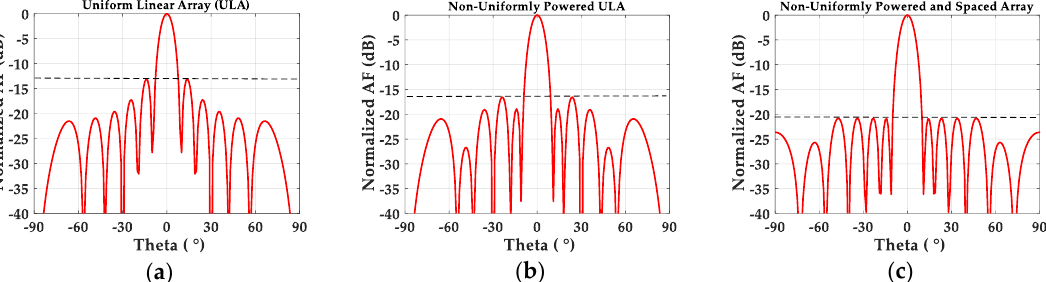
Figure 3. Normalized array factors of the 12-element array with ( a ) uniform amplitudes [1, 1, 1, 1, 1, 1] and uniform λ / 2-spacing, ( b ) non-uniform amplitudes [1, 1, 0.707, 0.707, 0.707, 0.707] and uniform λ / 2-spacing, and ( c ) non-uniform amplitudes [1, 1, 0.707, 0.707, 0.707, 0.707] and non-uniform spacing [0.459 λ , 0.528 λ , 0.454 λ , 0.421 λ , 0.548 λ , 0.598 λ ].